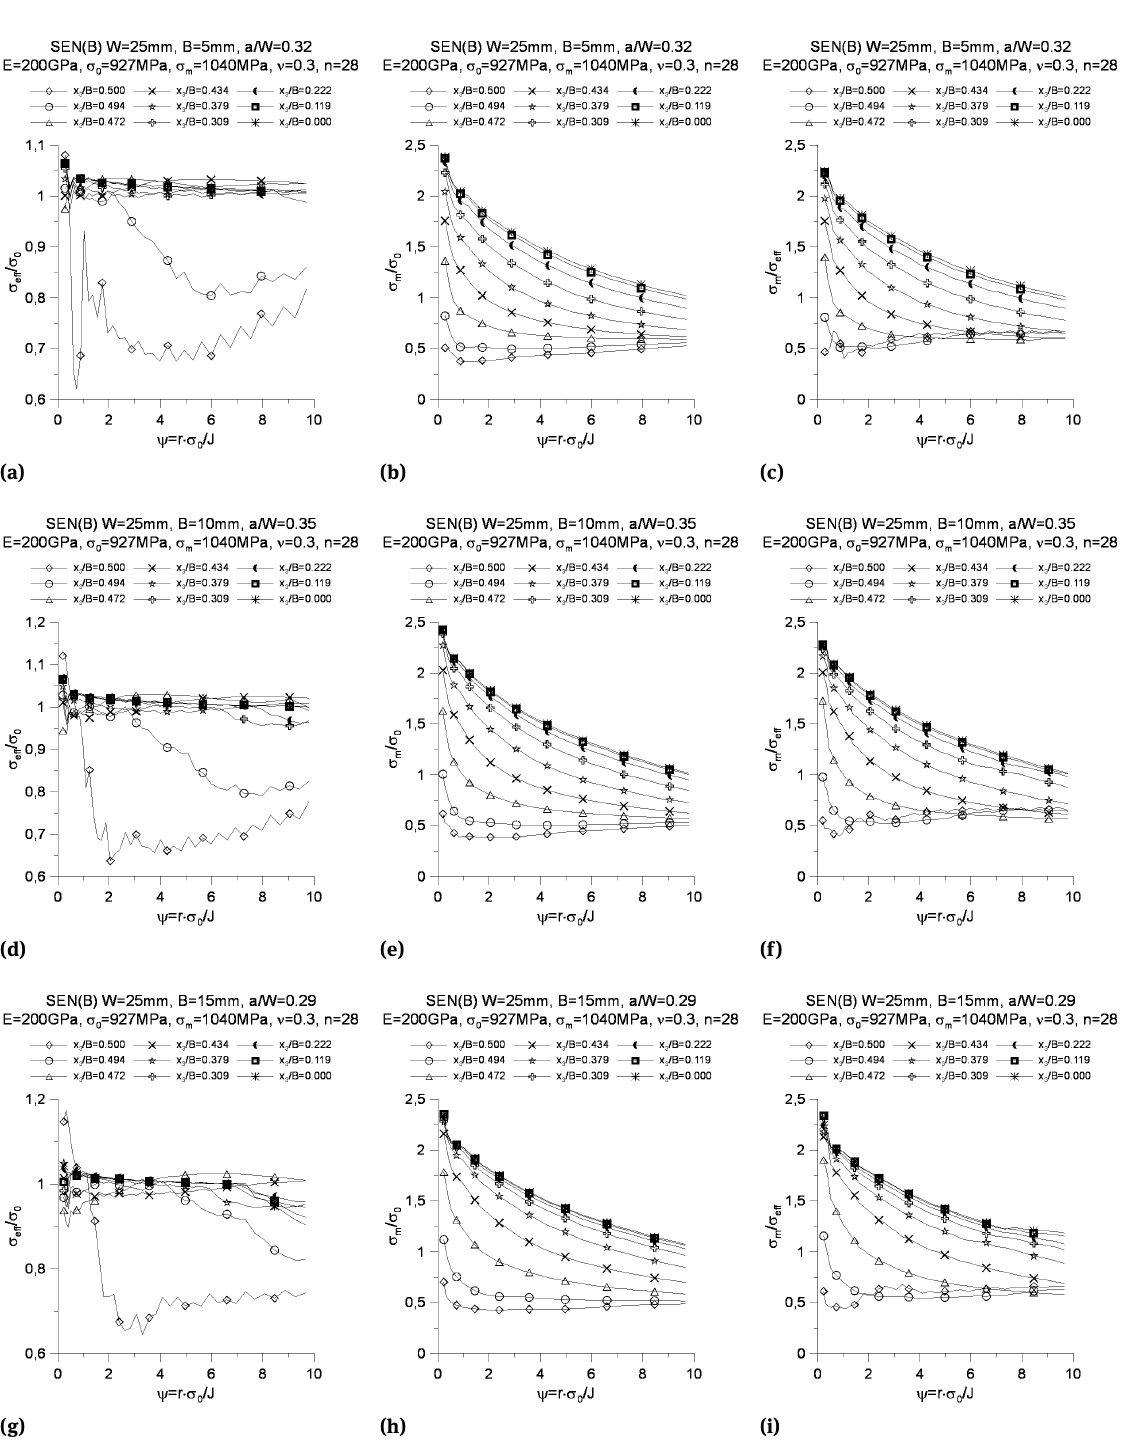
Figure 7: The distributions of the effective stress ( σ eff / σ 0 ), mean stress ( σ m / σ 0 ) and the ratio of the mean and effective stress ( σ m / σ eff ) – (which is also called as triaxiality parameter), near the crack tip for three SEN(B) specimens made of 145Cr6 steel: a-c) B = 5mm, a / W = 0.32 ; d-f) B = 10mm, a / W = 0.35 ; g-i) B = 15mm, a / W = 0.29 ( x 3 / B = 0.500 – the edge of the specimen; x 3 / B = 0.000 – the middle